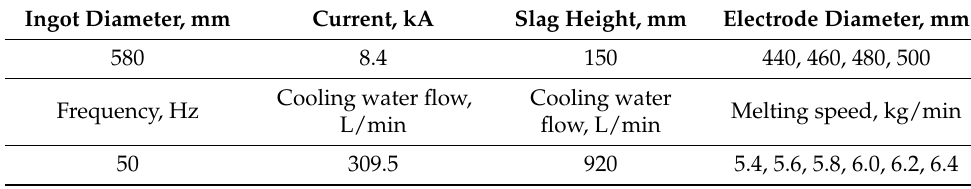
Table 2. Process parameters of the ESR.